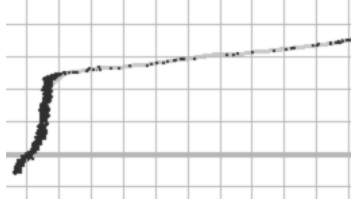
Figure 6. Cross sections with previously defined origin and orientation, Argilito area, Chavantes reservoir, August, 2013.